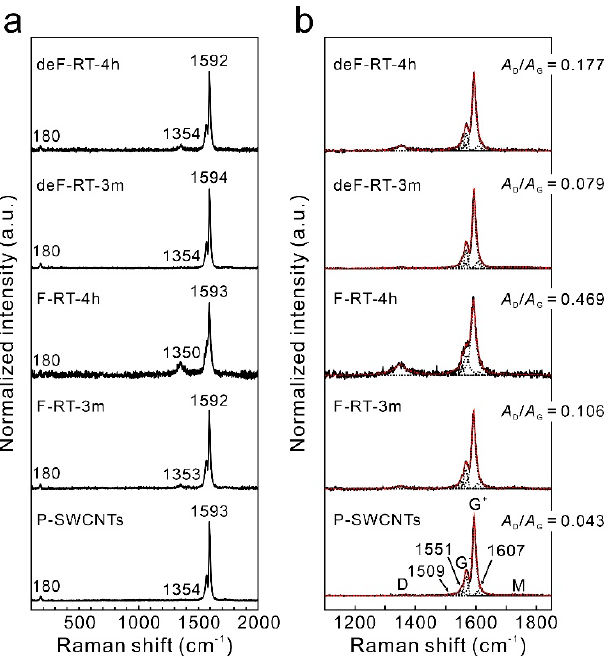
Figure 5. ( a ) Raman spectra of all samples in the range of 100–1850 cm − 1 . ( b ) Deconvoluted Raman spectra of all samples in the range 1100–1850 cm − 1 . The black and red dotted lines represent deconvoluted peaks and fitted curves, respectively.